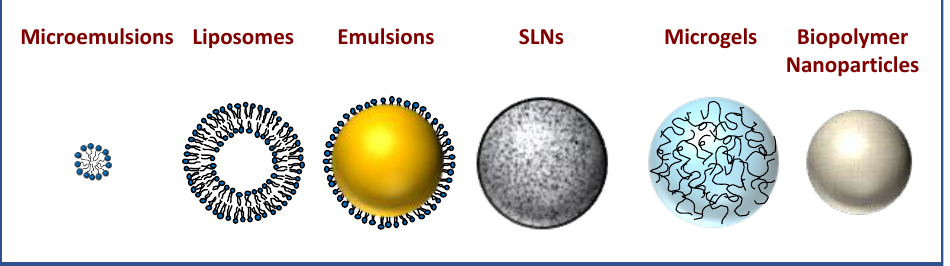
Figure 2. Examples of different kinds of colloidal delivery systems that can be used in foods and other end products.